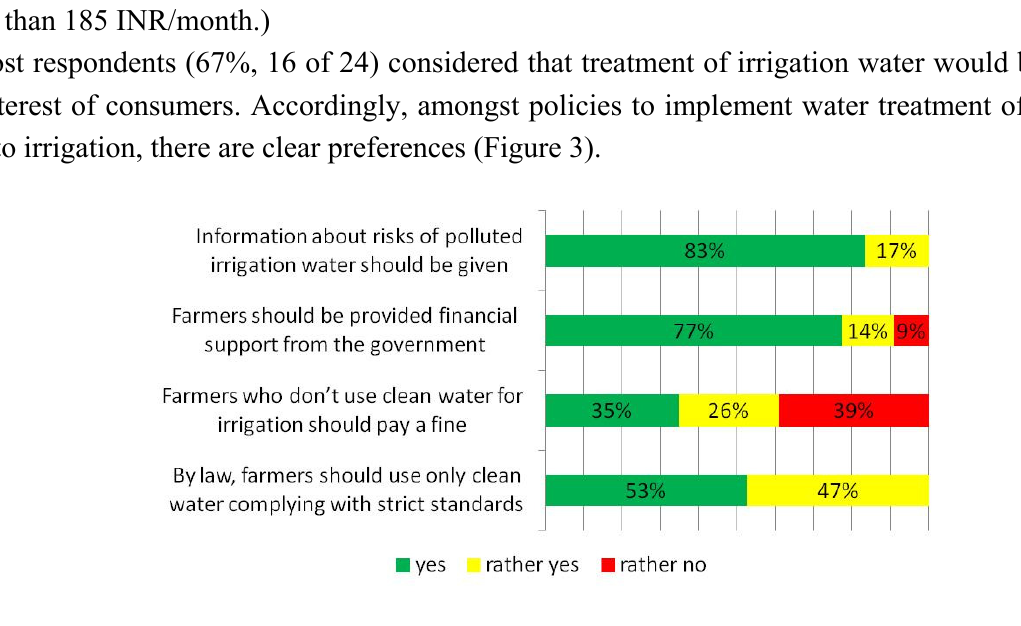
Figure 3. Views of consumers on policies to promote irrigation with cleaner